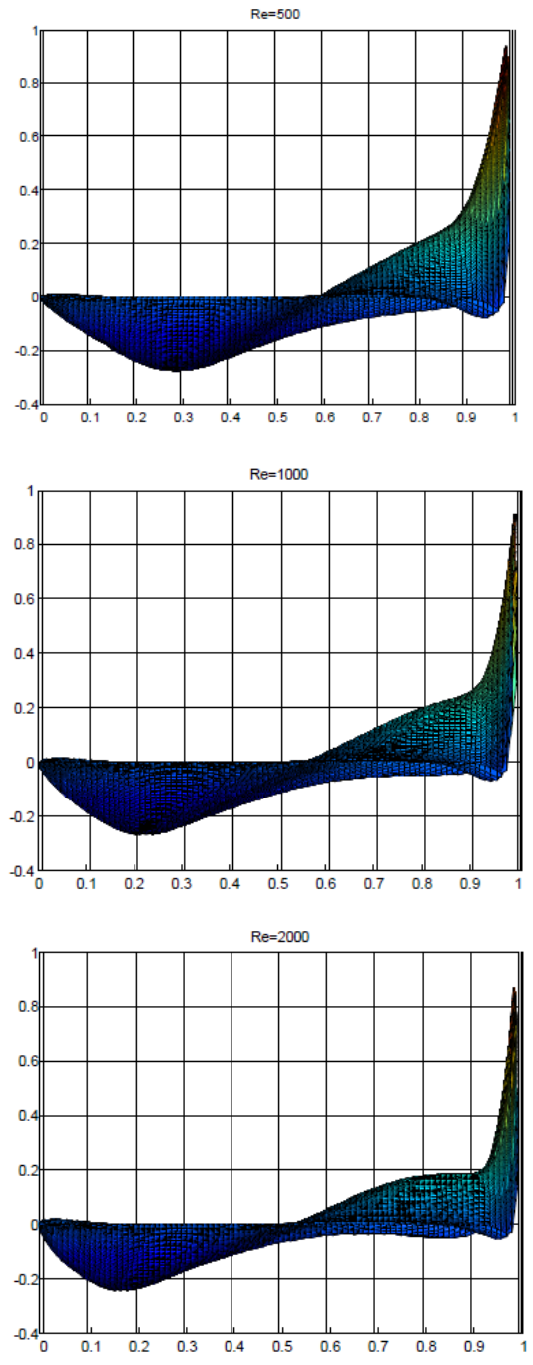
Figure 2. u- velocity at Re=500, Re=1000 and